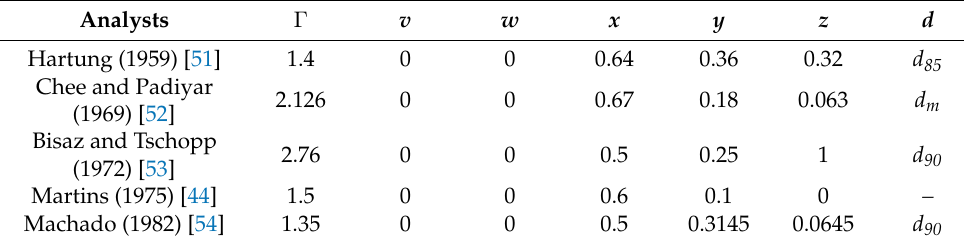
Table 5. Coefficients of five simplified scour